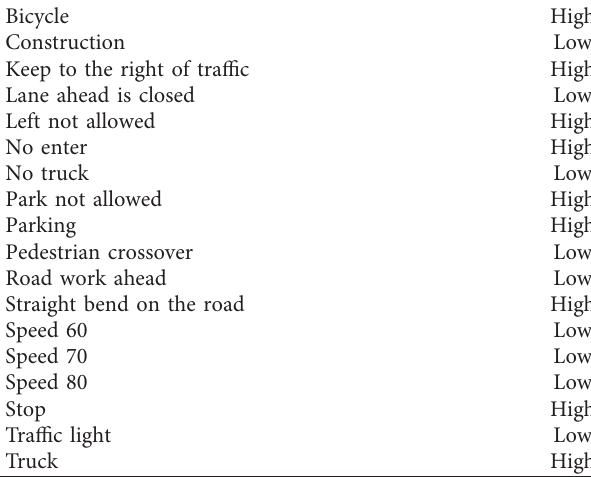
Table 4: Traffic sign categories outside 99% confidence interval. Bicycle High Construction Low Keep to the right of traffic High Lane ahead is